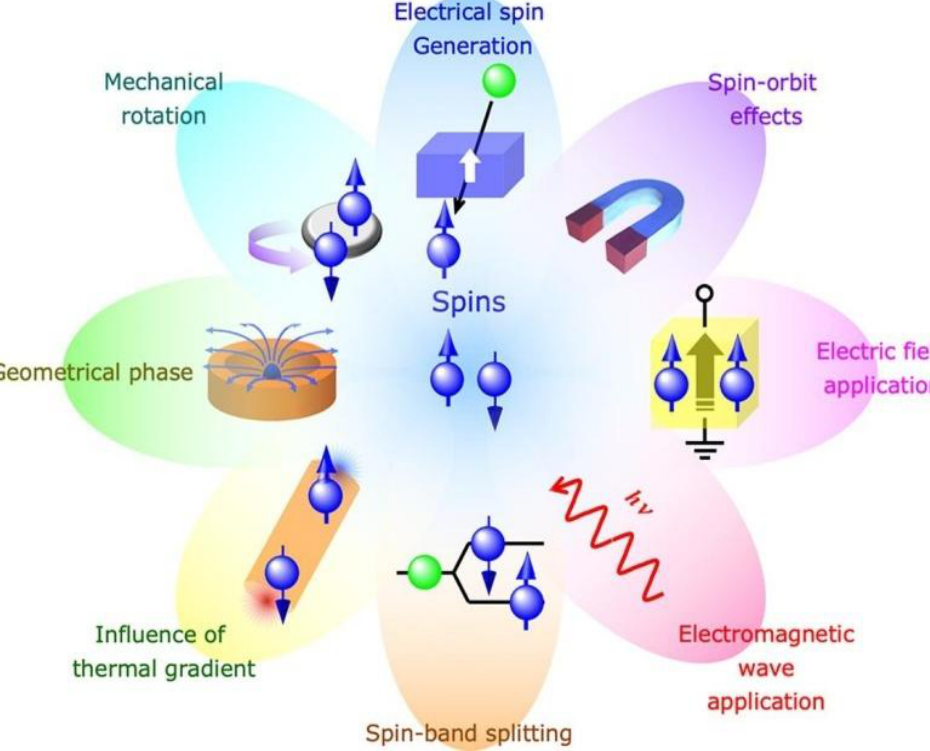
Figure 9. Graphical representation of spin with various aspect (Copyright © 2014, IOP) [93].